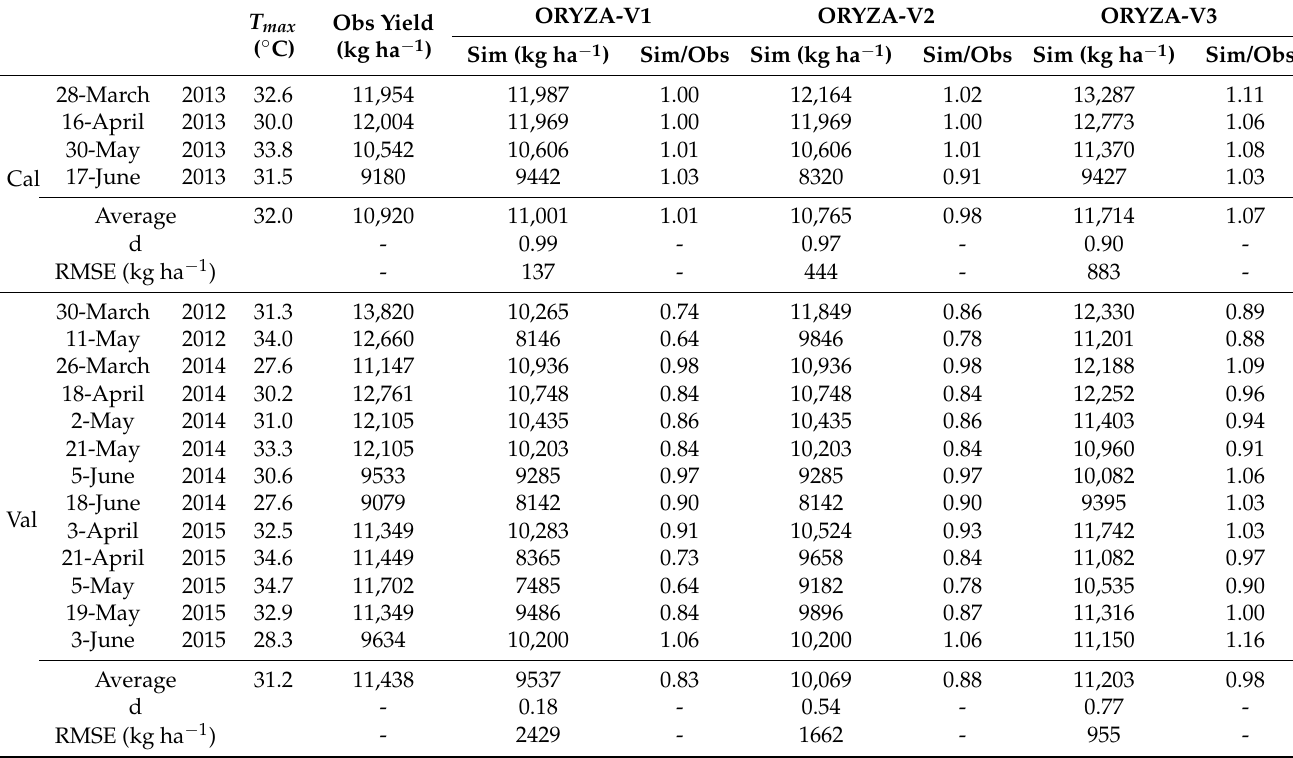
Table 5. Comparison of observed (Obs) and simulated (Sim) rice yield for the CLXL753 cultivar from three versions of ORYZA from field data at Stuttgart, Arkansas under varying planting dates from 2012 to 2015. Calibration (Cal) results for 2013 were shown (with values in Table S2) along with evaluation (Val) results for 2012, 2014, and 2015. The ratio of simulated to observed yield (Sim/Obs) was indicated along with Wilmott’s index of agreement and RMSE. Average maximum daily air temperature during flowering periods was shown as T max